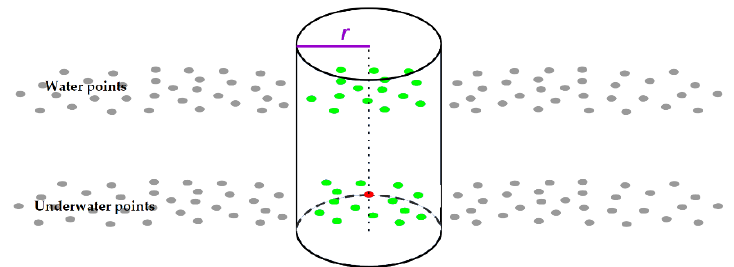
Figure 3. Visualization of the cylinder and analyzed points (red—analyzed point, green—points inside the cylinder used to compute the features, grey—other points in the point cloud, r —radius). Table 1 . Description of features used to train the ANN .